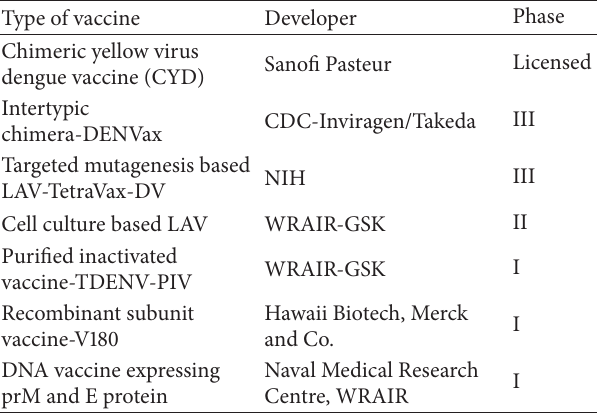
Table 2: Dengue vaccine candidates currently in different phases of clinical